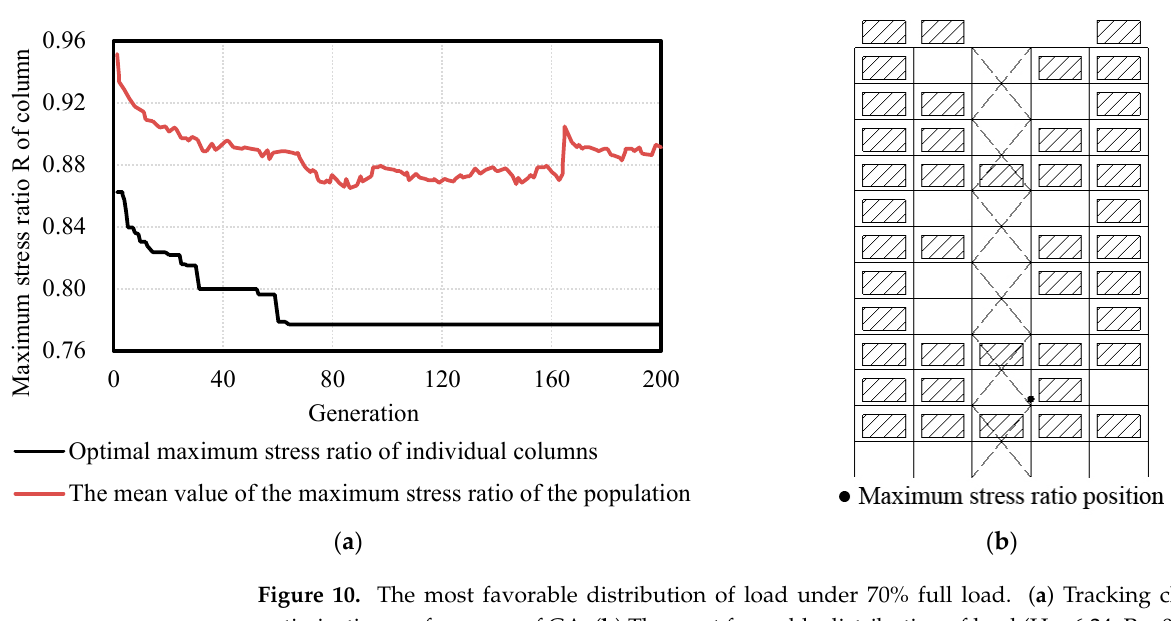
Figure 9. The most favorable distribution of load under 80% full load. ( a ) Tracking chart of optimi- zation performance of GA. ( b ) The most favorable distribution of load (H = 6.71, P = 0).